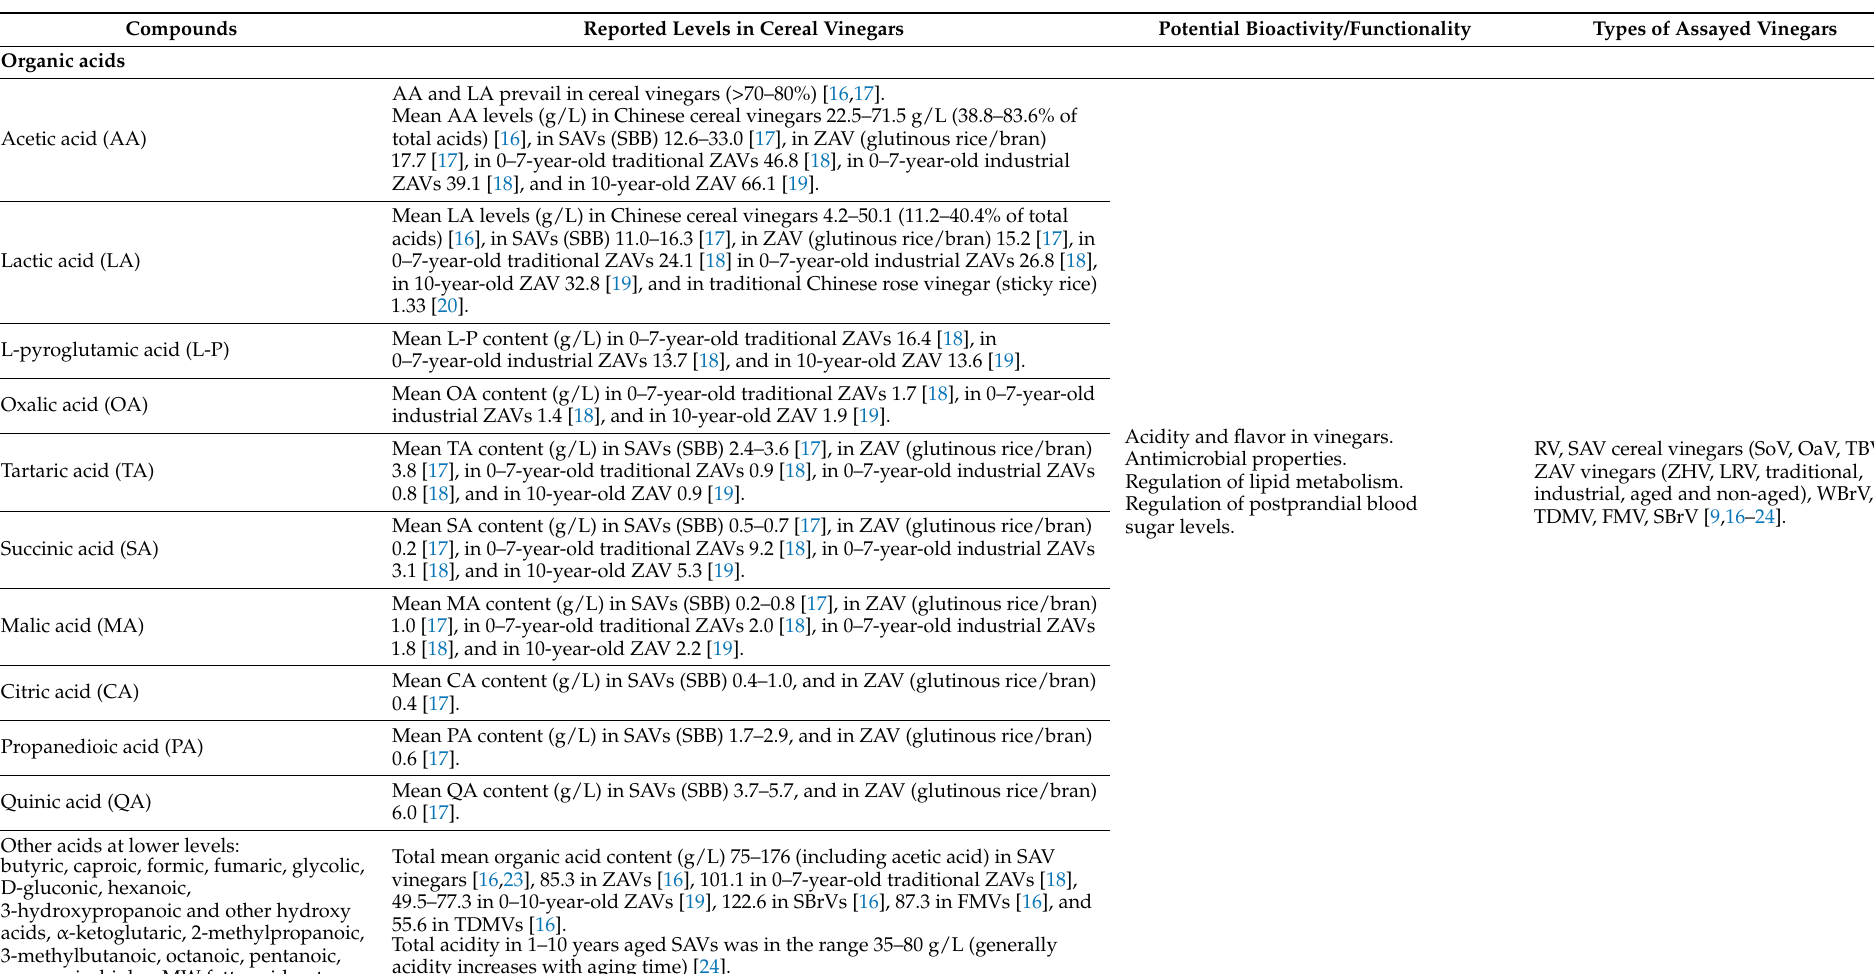
Table 1. Bioactive components in cereal